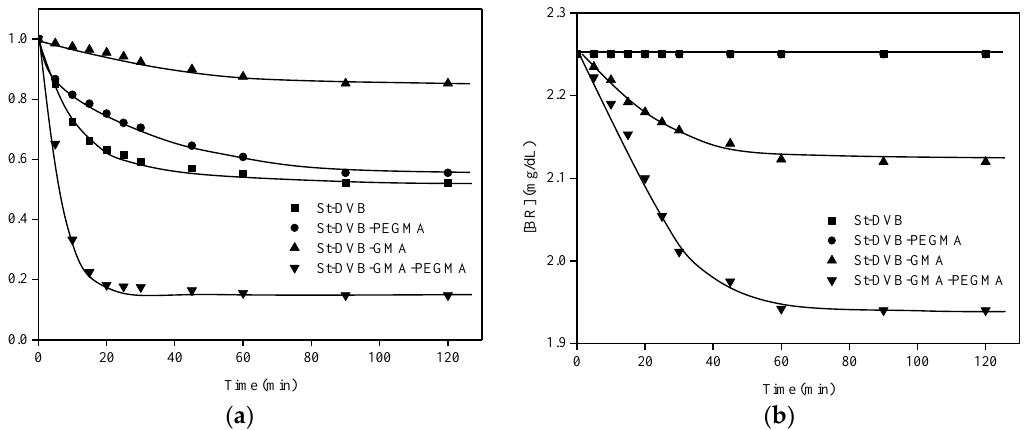
Figure 5. Kinetics of BR removal by non-pre-wetted particles without ( a ) and with BSA ( b ). Experi- ments without BSA were carried out with 7 g of particles and the experiments with BSA were carried out with 12 g of particles. T = 23 °C and Fr = 120 mL/min.